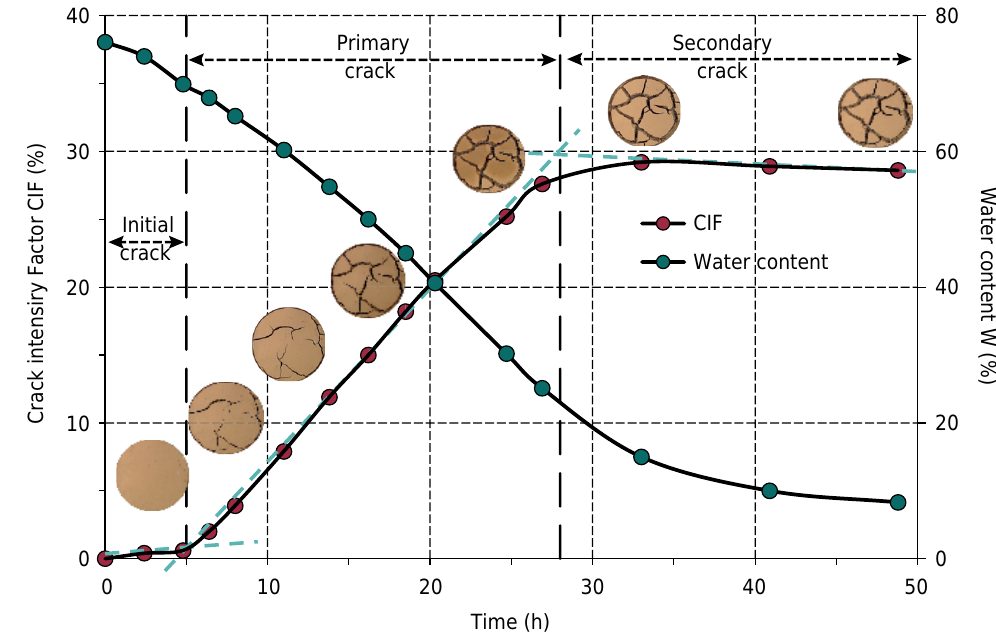
Figure 11. Soil behavior during crack